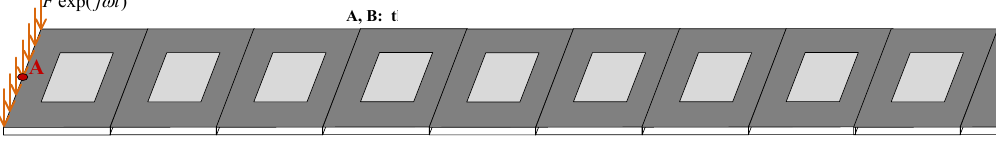
11 of 17 Figure 3. The real band gap diagram for the phononic plate: ( a ) with external fluid loading; ( b ) without the fluid loading. N denotes the number of elements.